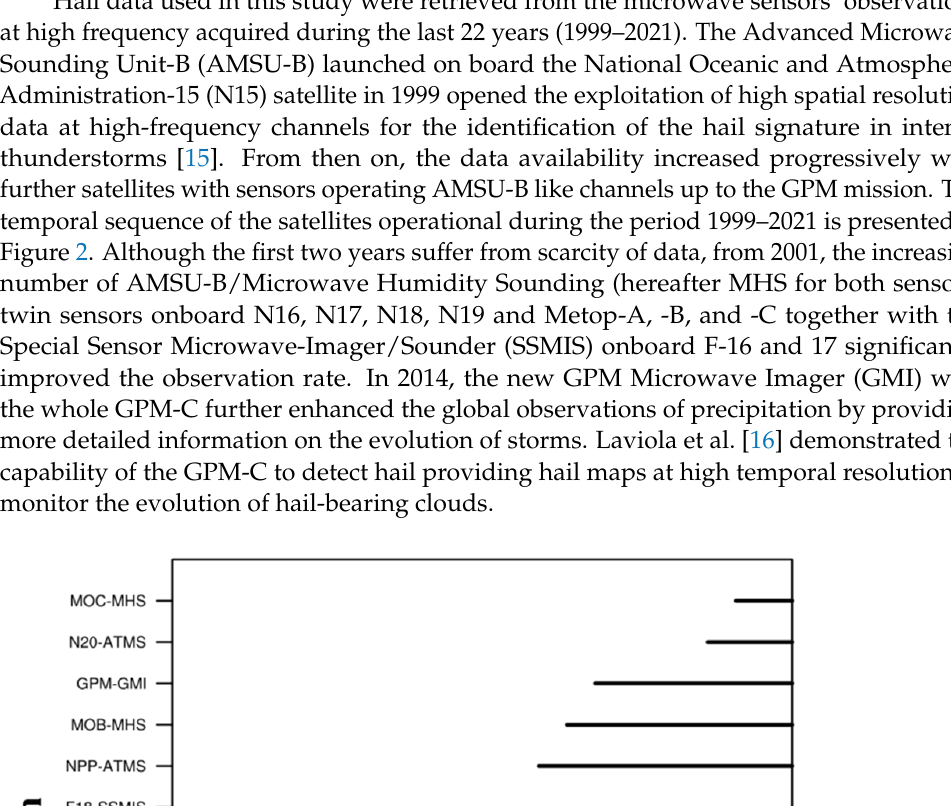
5 of 21 Table 1. MWCC-H hail categories as a function of the kinetic energy and potential severity at the ground. Category Description